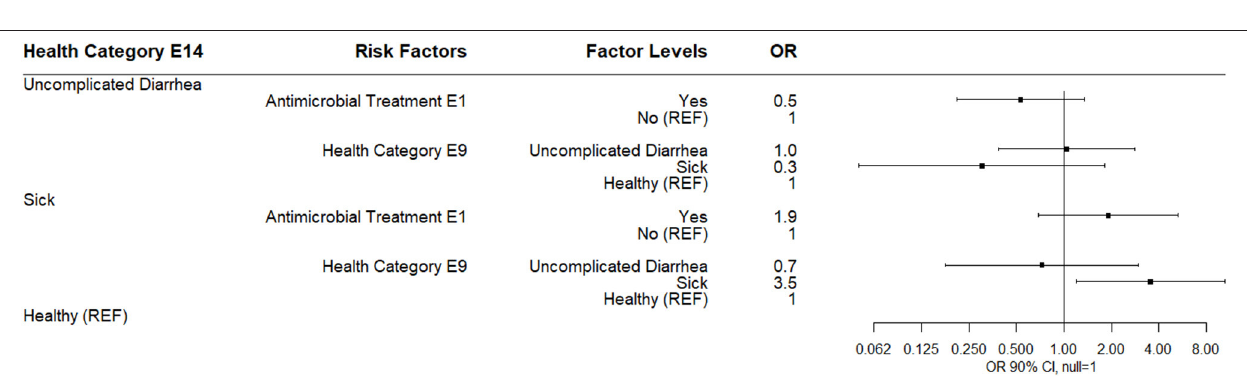
FIGURE 8 | Results of multinomial logistic regression modeling health category at sampling day E9. Odds ratios and 90% confidence intervals are shown.